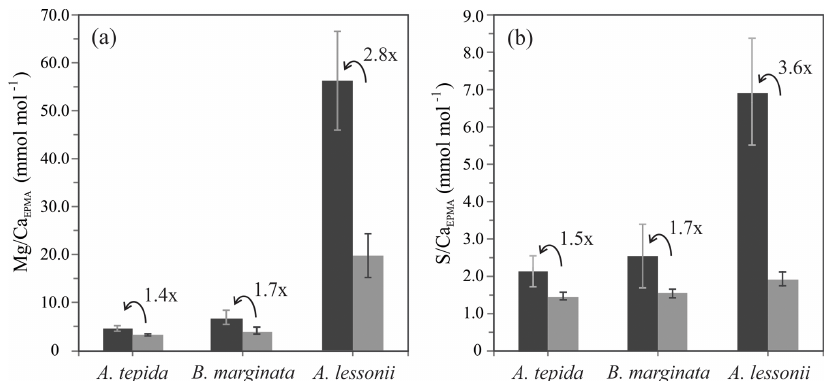
Figure 7. Average peak (black bars) and base (grey bars) values (Mg / Ca EPMA , panel a ; S / Ca EPMA , panel b ) with “peak factor” ( E/ Ca MAX /E/ Ca MIN ; see methodology Sect. 2.3.4 and Fig. 2) of three investigated species, low Mg species – A. tepida and B. marginata – and intermediate Mg species – A. lessonii . Error bars indicate 2SD. For details, see Table